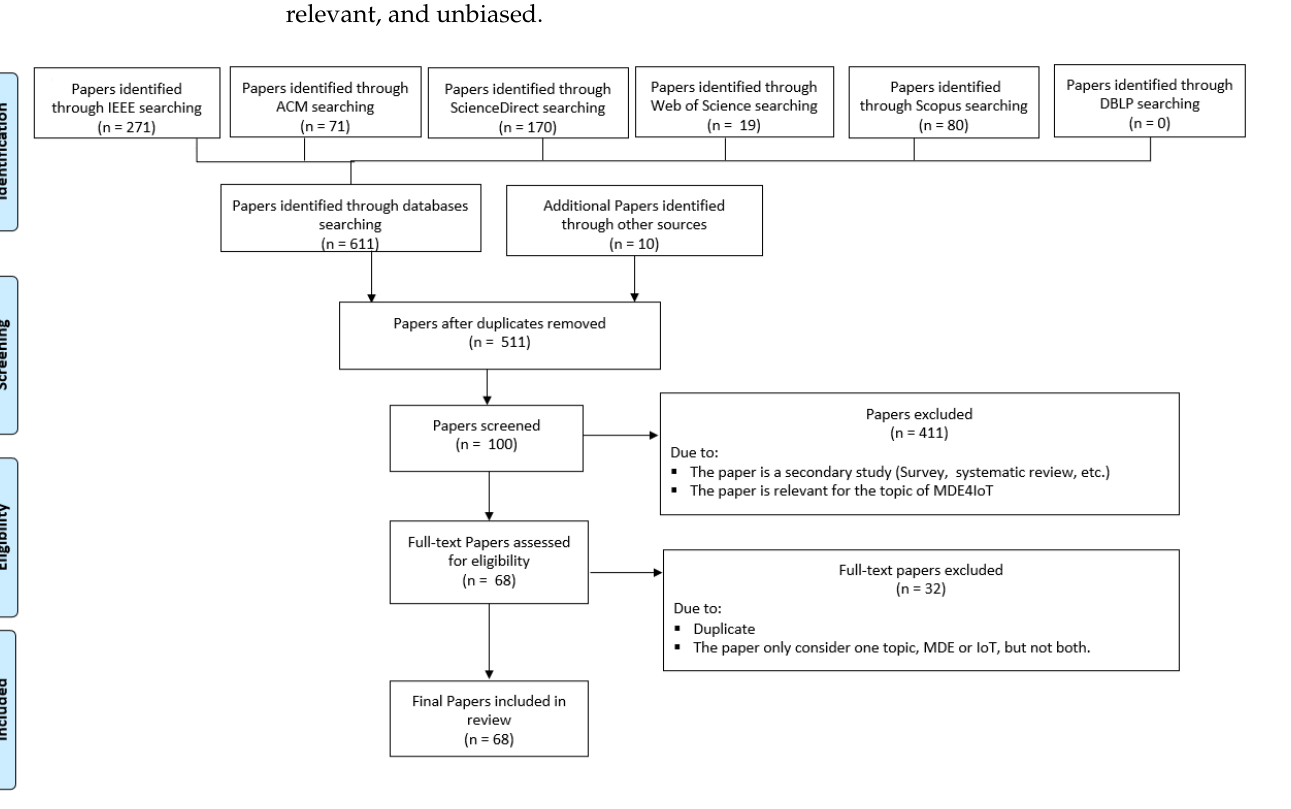
Figure 2. PRISMA flow diagram for paper